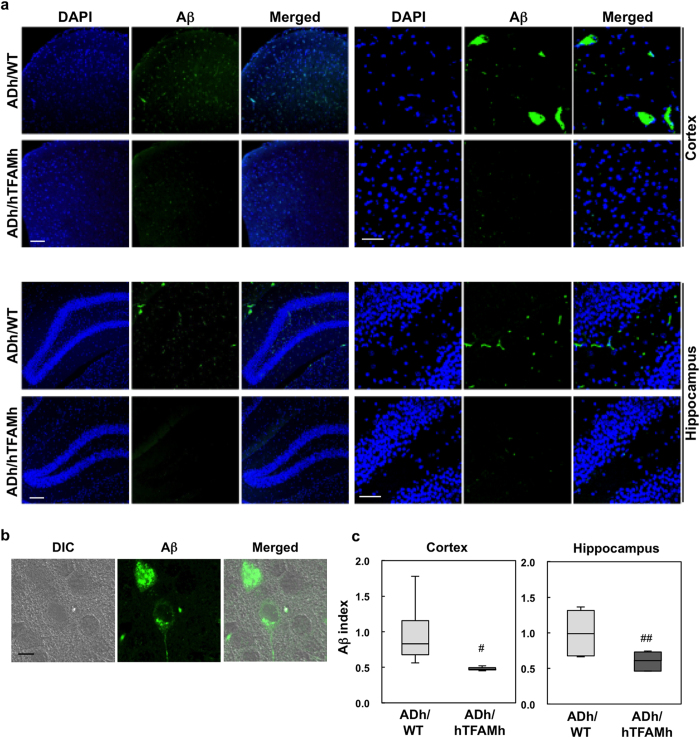
hTFAM suppresses Aβ accumulation in ADh/WT mice.(a) Immunofluorescence microscopy of Aβ in cortex and hippocampus of 13–14-month-old ADh/WT and ADh/hTFAMh mice using anti-human Aβ (N). Nuclei are stained with DAPI. Scale bar, 20 μm. (b) Intracellular localization of Aβ in the ADh/WT cortex. Cell morphology was confirmed by differential interference contrast microscopy (DIC) with Aβ immunofluorescence. Scale bar, 5 μm. (c) Quantitative measurement of Aβ immunofluorescence. Aβ immunofluorescence was measured as described in Supplementary Fig. S3, and the relative intensity (Aβ index) is shown in whisker-box plot. Kruskal–Wallis rank sum test: cortex, #p = 0.0433, hippocampus, ##p = 0.0209, n = 3–4.